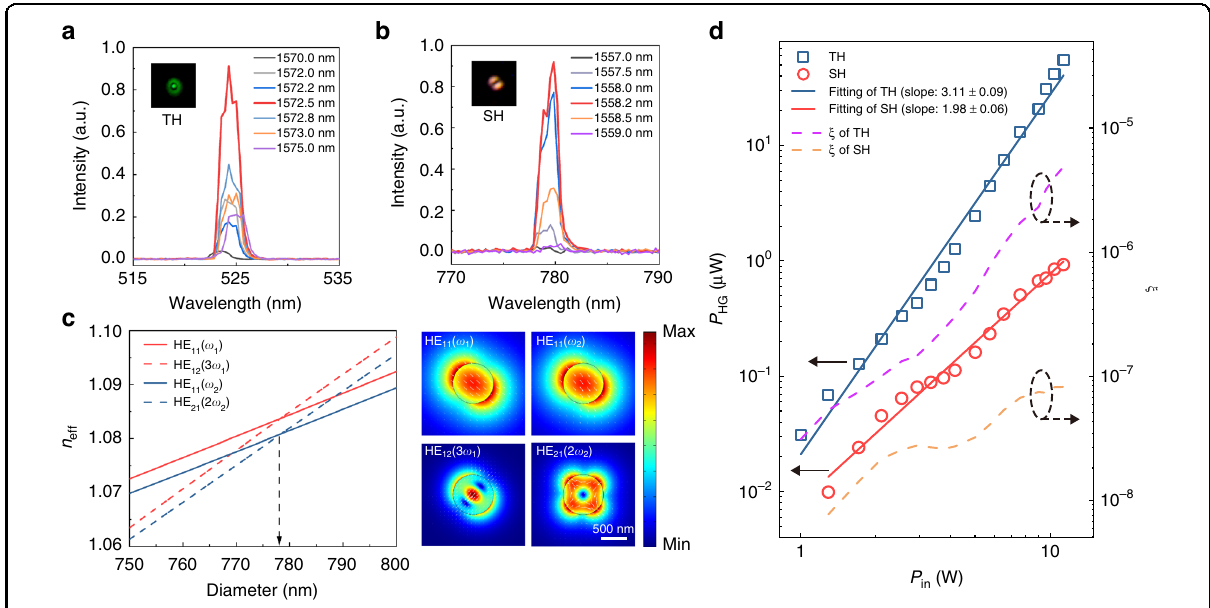
Fig. 4 Phase-matched CW harmonic generation in MNFs. a , b Experimentally measured THG ( a ) and SHG ( b ) spectra in a 779-nm-diameter, 7-cm- length MNF waveguiding a 5-W-power light. To search the optimal phase matching condition, the wavelength of the light is scanned from 1570 nm (1557nm) to 1575 nm (1559 nm) for THG (SHG). Insets, optical microscope images of output spots of the TH and SH at the endface of the standard fi bre connected with the MNF. c Calculated effective refractive indices ( n eff ) of the fundamental (HE 11 ) and high-order (HE 12 and HE 21 ) modes showing phase-matching condition at two intersection points with nearly the same diameter of ∼ 779 nm at wavelengths of λ 1 = 1572.5 nm for THG (blue lines) and λ 2 = 1558.2 nm for SHG (red lines), respectively. Inset, calculated fi eld intensity pro fi les of phase-matched waveguiding modes for THG and SHG, respectively. d Dependence of the output power ( P HG ) of THG/SHG on the waveguided power ( P in ). The fi tting slopes for the THG and SHG are 3.11 ± 0.09 and 1.98 ± 0.06, respectively. ξ , conversion ef fi ciency of harmonic